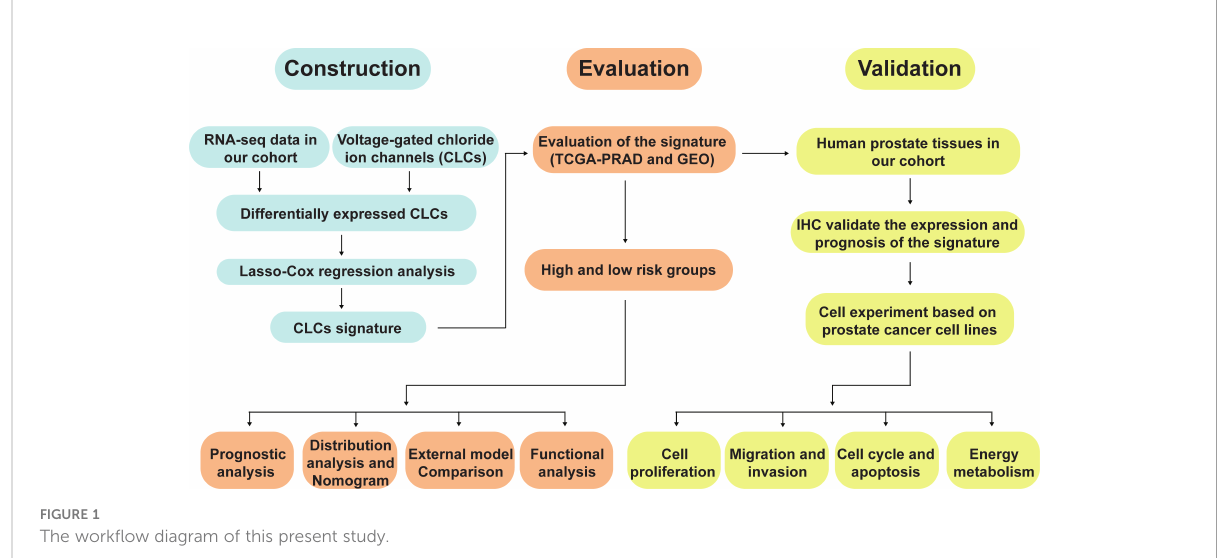
FIGURE 1 The work fl ow diagram of this present